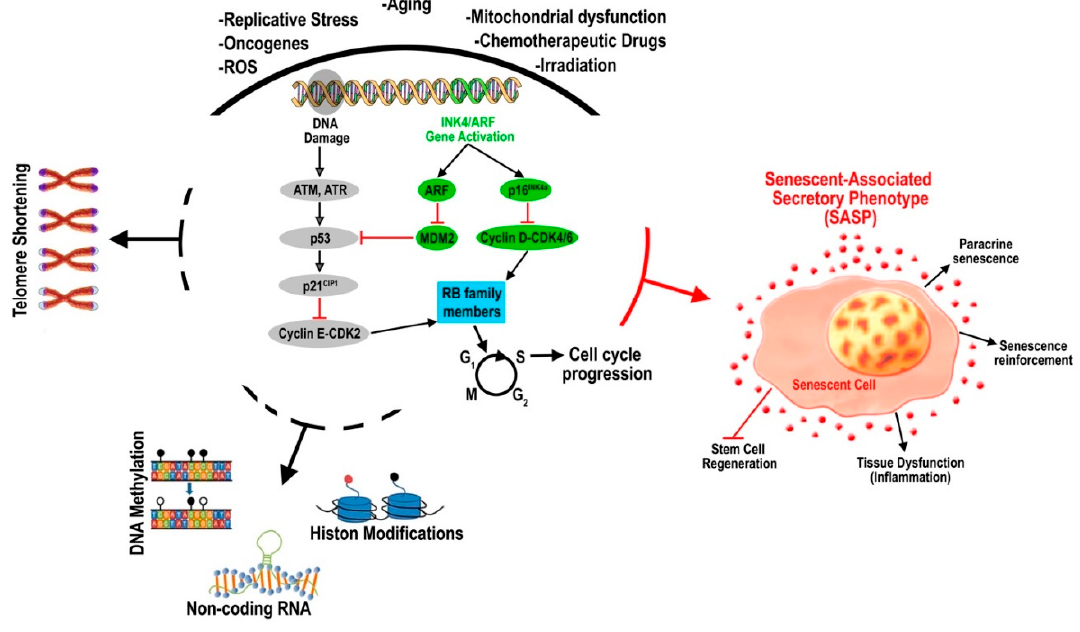
Figure 2. Molecular and Cellular Mechanisms of Senescence: A variety of stressors induce replicative senescence by the induction of the p16 INK4a / ARF and p53 / p21 CIP1 pathways converging on the Rb family members to block cell growth. Telomere shortening and epigenetic modifications contribute to the senescent status. These molecular modifications progress to the development of the SASP that amplify senescence through cell-to-cell connections that modify tissue homeostasis, repair, and function.